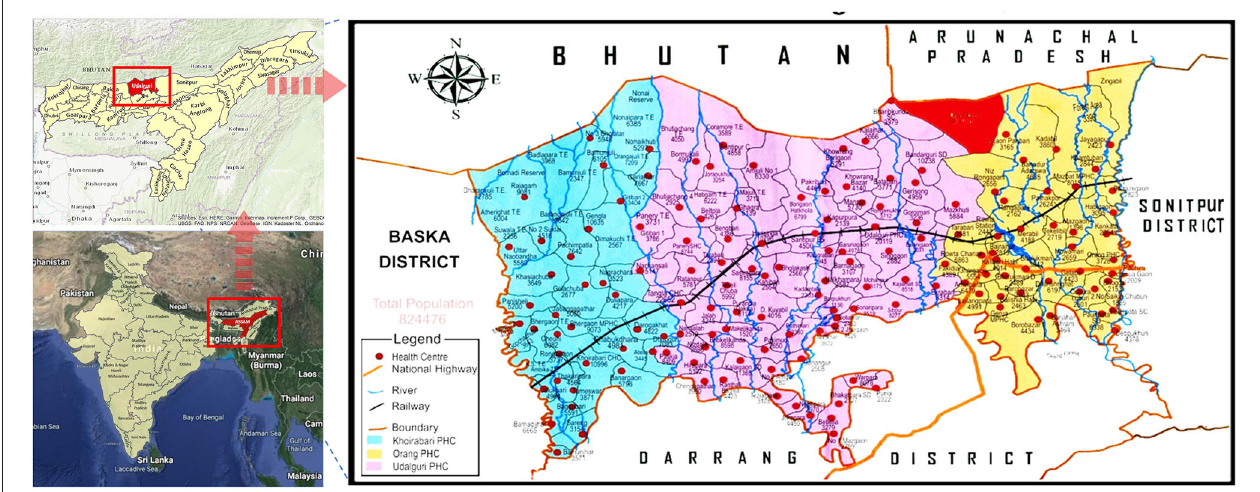
FIGURE 1 | Map of study area (Red color depicts the area covered under the Dolonibasti sub-center).